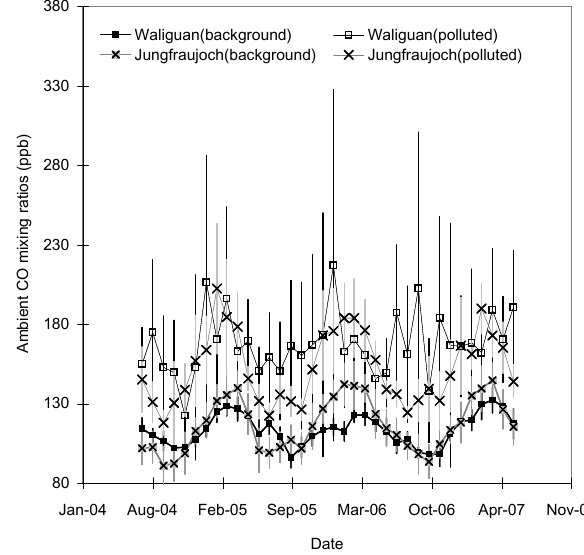
Fig. 6. Monthly mean mixing ratios of ambient CO and its standard deviations at Waliguan and Jungfraujoch for both air identified as background and as polluted.